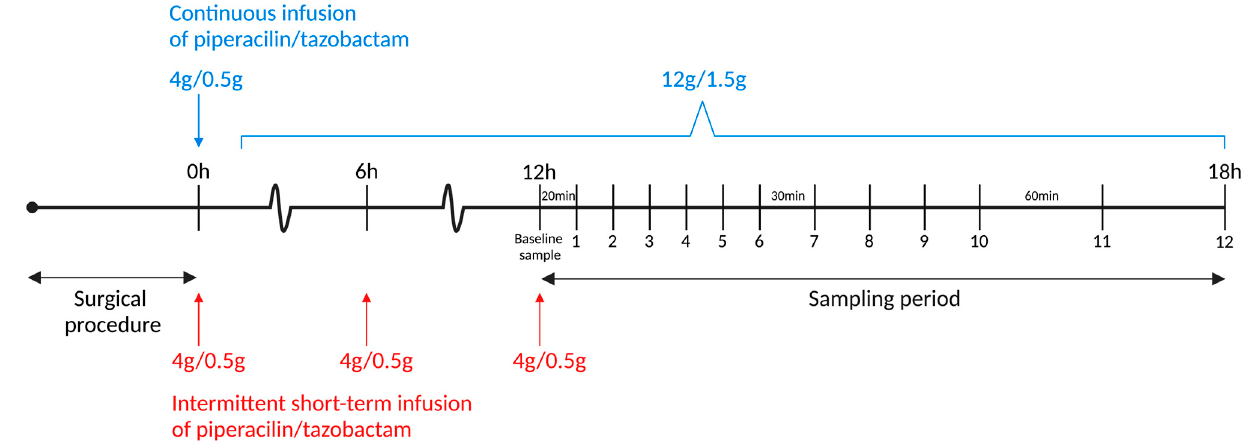
Figure 2. Timeline illustrating piperacillin/tazobactam dosing and sampling in the two administra- tion groups. Created with BioRender.com.